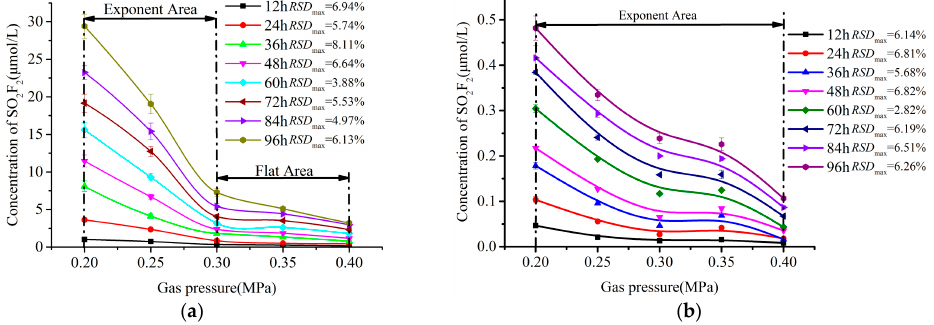
Figure 7. Correlation between SO 2 F 2 concentration and pressure: ( a ) Protrusion and ( b ) particles.